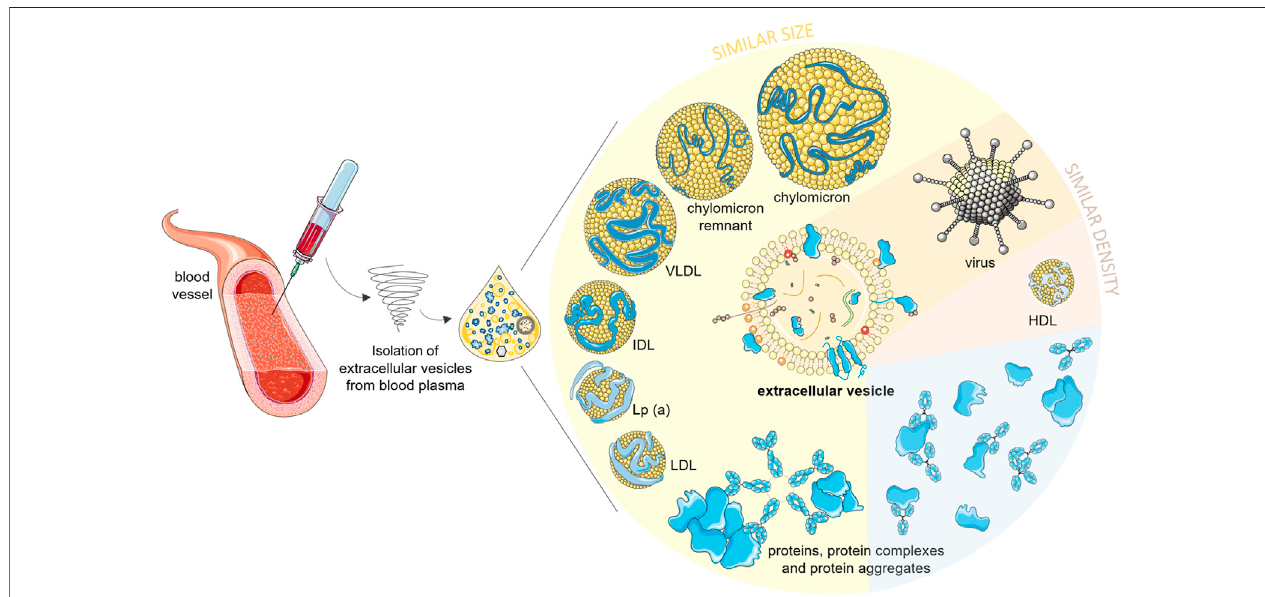
FIGURE 1 | Possible nano-sized contaminants in an extracellular vesicle isolate of blood plasma. Lipoproteins larger than high density lipoproteins (HDLs) and larger protein aggregates/complexes are similar to EVs in size. HDLs have similar density, and viruses can be of similar density and size as EVs. Soluble proteins are smalleranddenserthanEVs,buttheycanformaproteinbiocoronaaroundEVsoraggregatewithanyothernanoparticlesduringtheisolationprocedures,whichwillalso contribute to contamination of EV isolates. EVs, extracellular vesicles; HDLs, high density lipoproteins; LDL, low-density lipoproteins; Lp(a), lipoprotein a; ILDs, intermediate-density lipoproteins; VLDLs, very low density lipoproteins. Part of this fi gure was modi fi ed from SMART (Servier Medical Art), licensed under a Creative Common Attribution 3.0 Unported License.